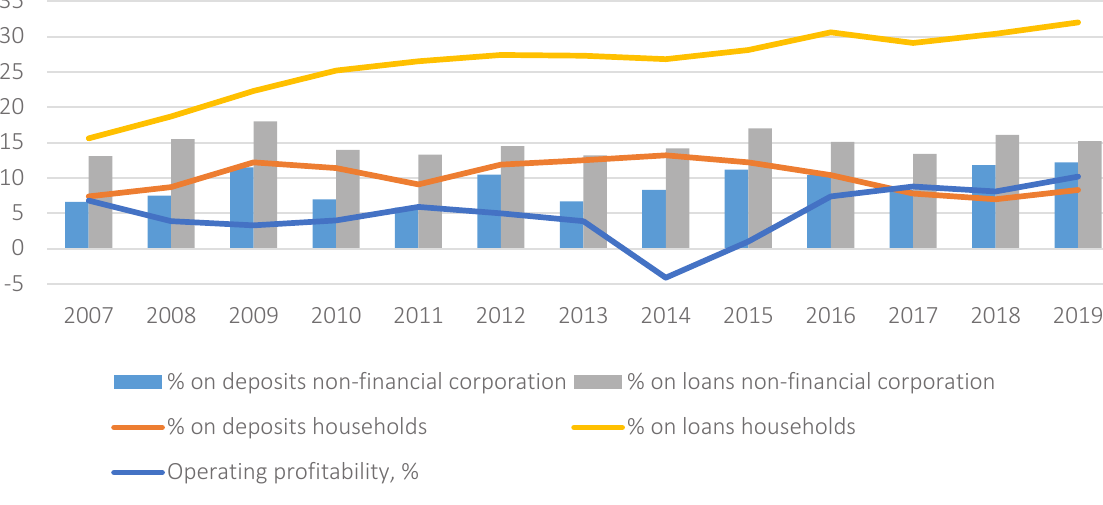
Figure 4. Dynamics of rates on deposits and loans and operating profitability of economic entities